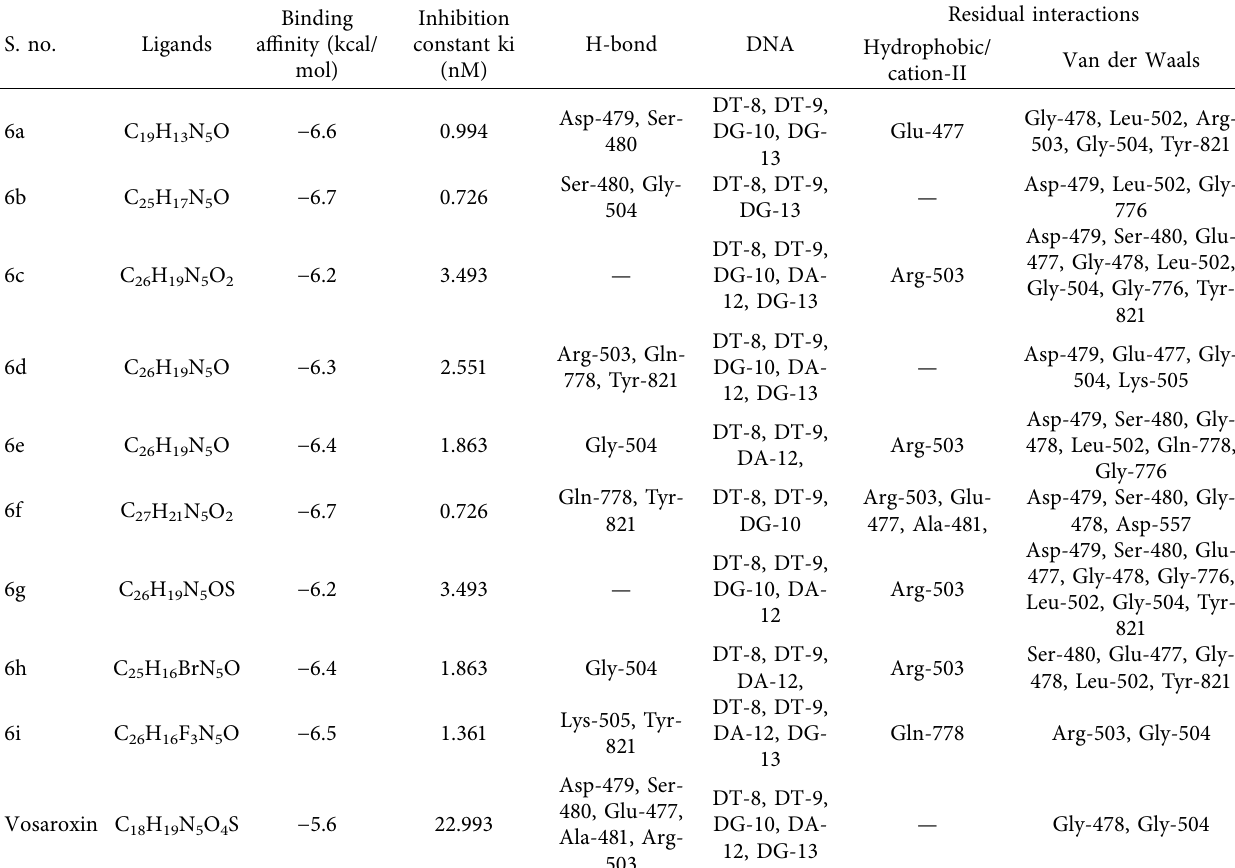
Table 4: Molecular docking results of compounds 6a-i against human topoisomerase II β DNA (PDB ID 3QX3). S.